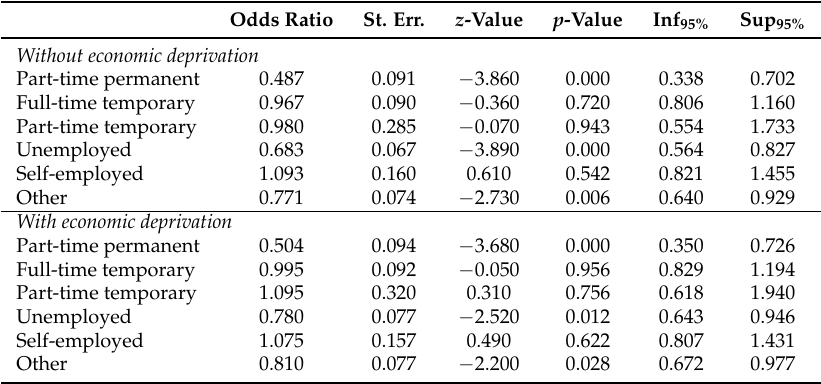
Table 9. Correlated random-effects ordered logit model: estimated odds ratios for employment status (ref.: Full-time permanent)—Eastern countries. Odds Ratio St. Err. z -Value p -Value Inf 95% Sup 95% Without economic deprivation Part-time permanent 0.487